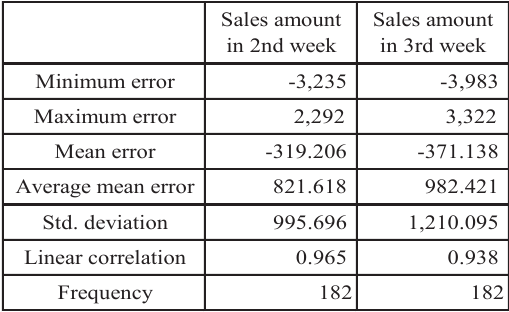
Table 4. Accuracy analysis on the basis of learning data.